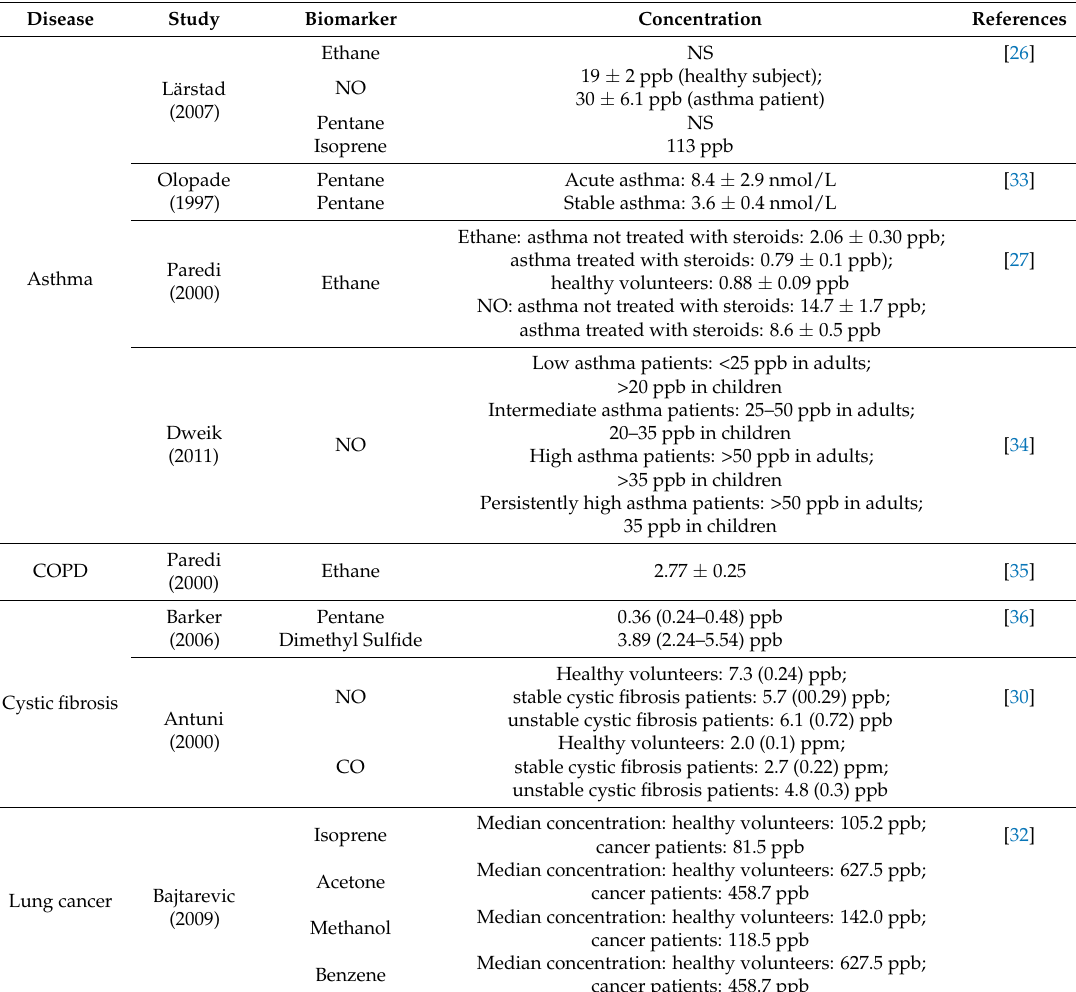
Table 2. Concentrations of biomarkers used in the detection of different diseases. NS, not stated; ppb, parts per billion; ppmv, parts per million by